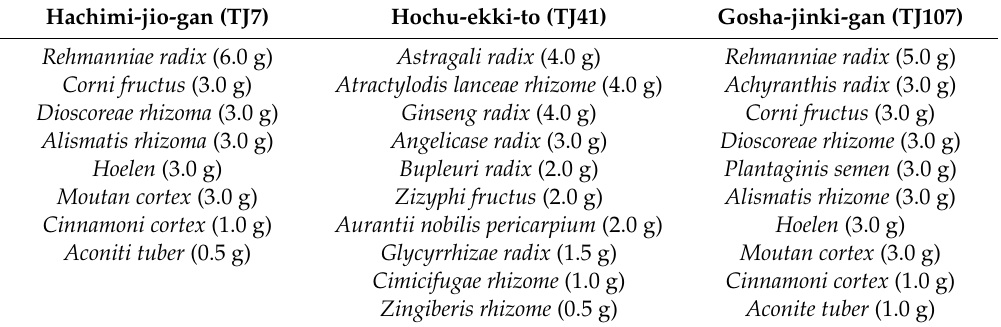
Table 1. Medicinal components of Hachimi-jio-gan, Hochu-ekki-to, and Gosha-jinki-gan (ratio). Hachimi-jio-gan (TJ7) Hochu-ekki-to (TJ41) Gosha-jinki-gan (TJ107) Rehmanniae radix (6.0 g) Astragali radix (4.0 g) Rehmanniae radix (5.0